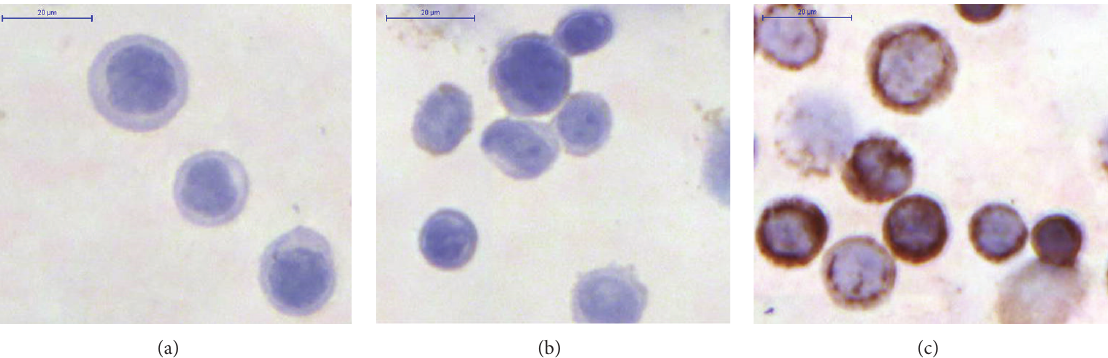
Figure 4: Toll-like receptor 9 immunocytochemistry. (a) Negative control; (b) immunonegative HT29 cells; (c) immunopositive (brownish immunoreaction) HT29 cells (200x magnification, hematoxylin costaining).